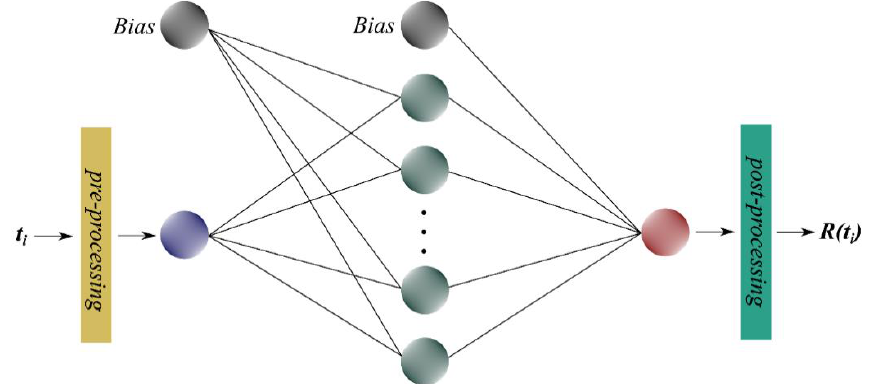
Figure 3. Graph of neural network for reliability modelling.